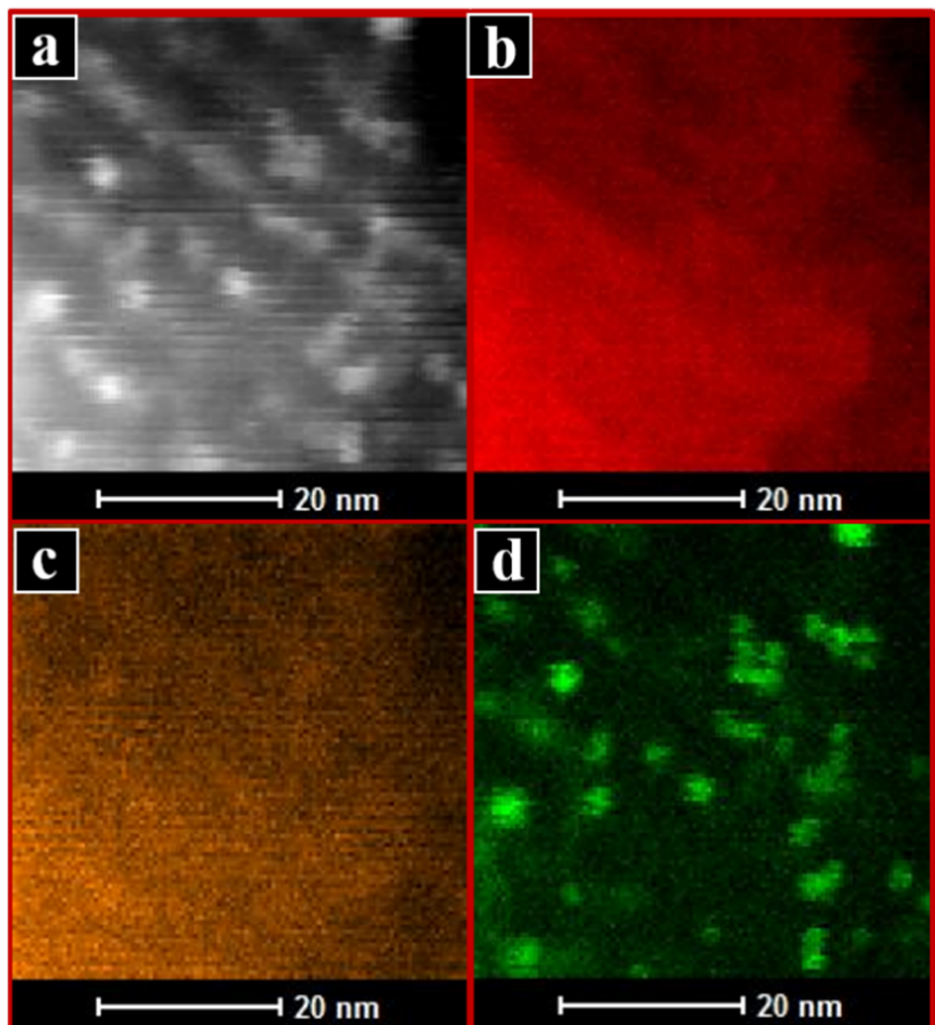
Figure 6. HAADF image of the catalyst DS-Pd after HDC testing in which Pd has bright contrast ( a ), and corresponding EDS elemental maps for: C ( b ), showing the parallel pore structure; O ( c ); and Pd ( d ), confirming the presence of Pd nanoparticles inside the mesopores of the support.